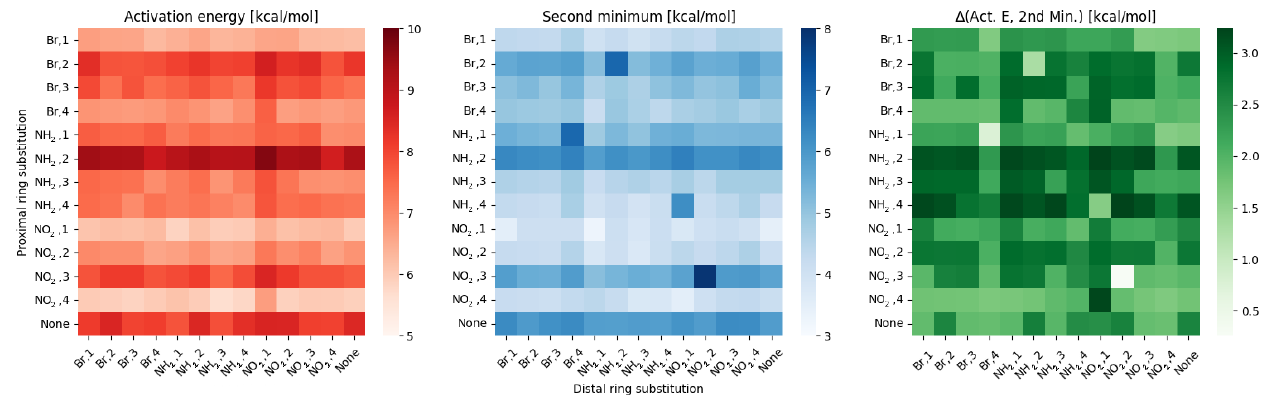
Figure 4. Heatmaps of the activation energy ( left ), second minimum ( middle ) and the difference between them ( right ) for different substitution patterns in the ortho compounds